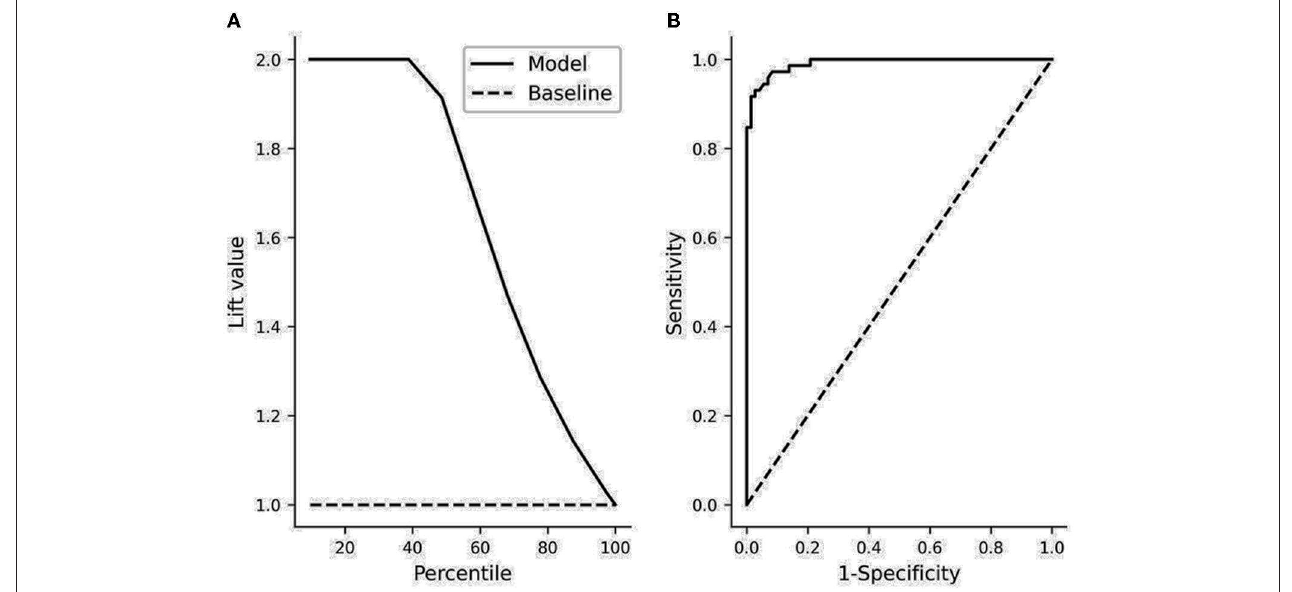
FIGURE 7 | Overall model performance of the stepwise logistic regression. (A) The lift chart shows the ratio (lift value) of correct predictions based on deciles (percentile) of the sample (i.e., axons) ordered by decreasing the predicted probability to that of a random sample. At the full sample size (100%), the lift value equals 1. In the final model (solid line) with a threshold value of 0.5 for up to about 40% of the axons, there were two times as many correct predictions as in the case of the same percentage of axons selected randomly (dashed line). Also, a quick decline in the elevation value after about 40% shows that the inclusion of more axons did not increase the ratio of correct prediction relative to that of a random sample. (B) Receiving operating characteristics (ROC) of the model. The area under the ROC curve (0.99) indicates a very high accuracy. The solid line shows the accuracy of the model whereas the dashed line shows the performance if axons were randomly classified. Sensitivity: true positive rate, 1-specificity: false positive rate. A perfect classifier would have a true positive rate of 1 with a false positive rate of